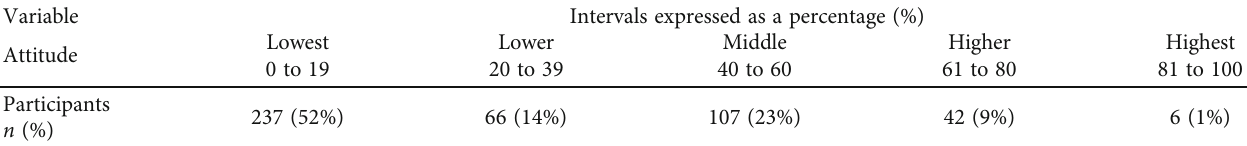
Table 3: Attitude scores among study participants.